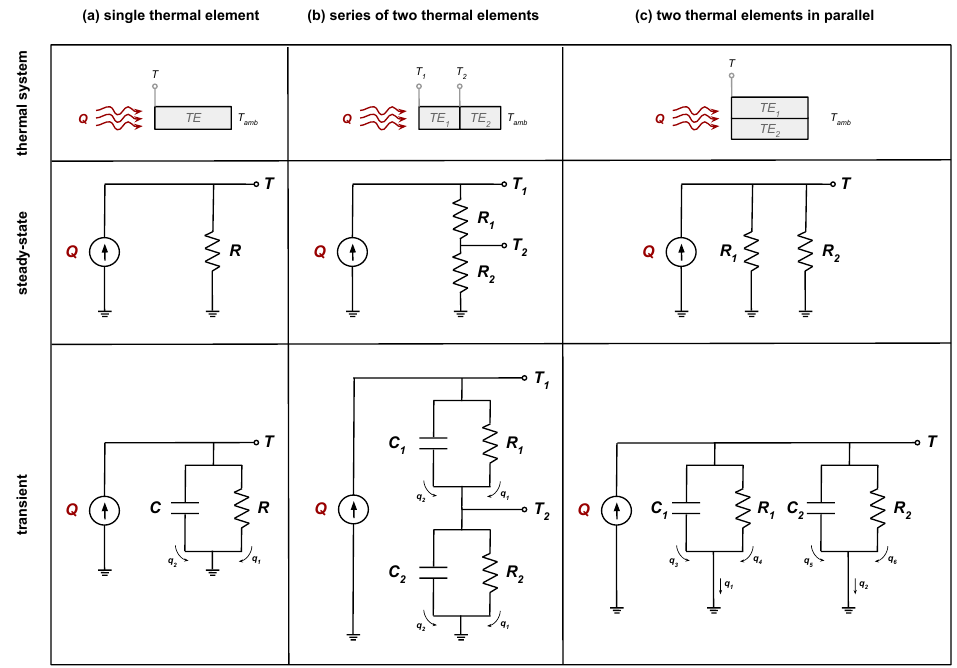
Figure 2. Thermal systems used for the validation of the proposed model and equivalent thermal circuits for the steady state and transient responses: ( a ) single thermal element; ( b ) series of two thermal elements; ( c ) two thermal elements in